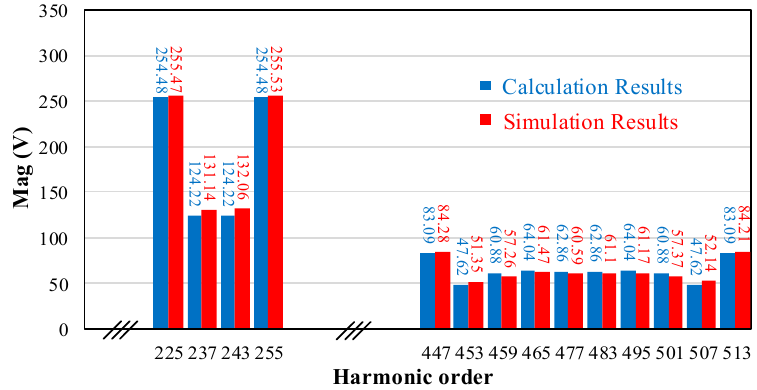
Figure 9. A comparison of magnitude values of CMV harmonics in the theoretical calculation and the simulation results.